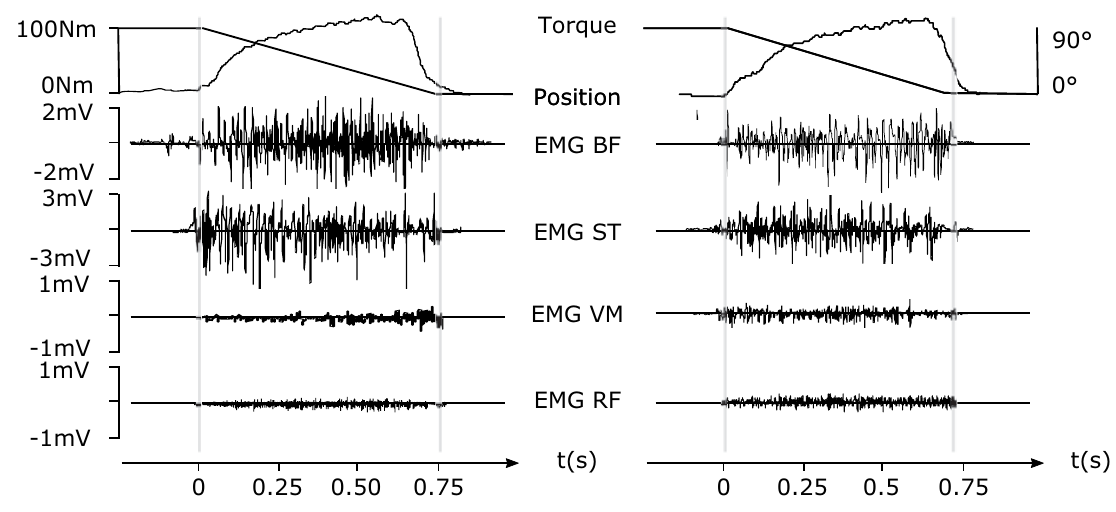
Fig 2. Raw tracings of isokinetic knee torque and electromyogram (EMG). They obtained in a male elite soccer player in the paradigm of maximal eccentric knee flexion contraction during joint movements performed at slow ( A ) and fast ( B ) joint angular speeds (30˚/s and 120˚/ s, respectively) illustrated for the unaffected leg (left) and the affected leg with a history of MSI. Range of joint motion was from 90˚ to 0˚ (0˚ = full knee extension). Upper tracings display the joint torque and position signal. Lower tracings display raw EMG signals recorded from the biceps femoris (BF), semitendinosus (ST), vastus medialis (VM), and rectus femoris (RF) muscles. EMG was lower in the MSI affected compared with the unaffected leg, suggesting significant neural inhibition after MSI. Note the appearance of large EMG amplitude spikes separated by short inter spike periods of high neuromuscular activity in the BF and SMT of the unaffected leg as compared to the affected leg. Furthermore, torque and EMG amplitudes were diminished on the MSI affected side, especially during eccentric and fast concentric contractions ( B